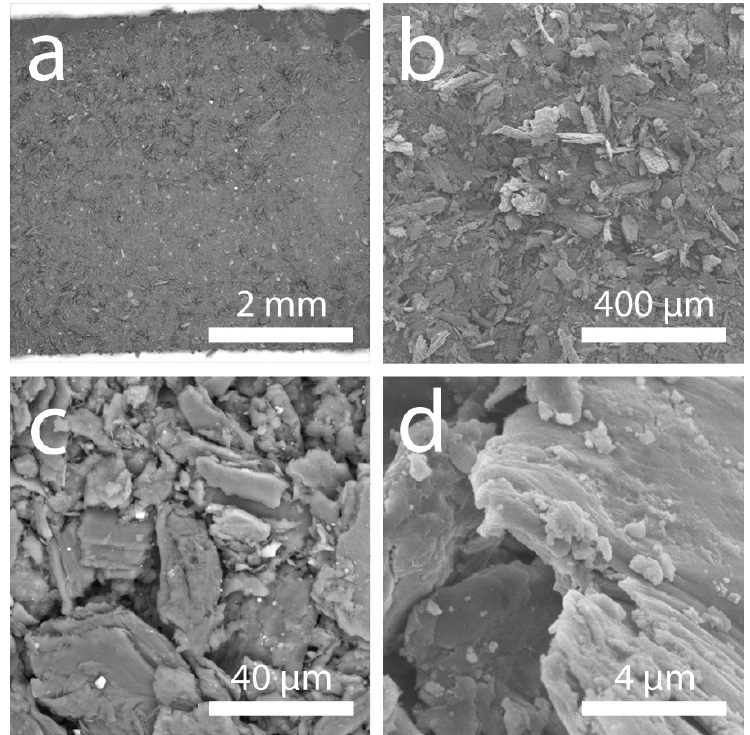
Figure 4. SEM images of the surface of wheat straw particles at di ff erent magni fi cations ( a – d ) .